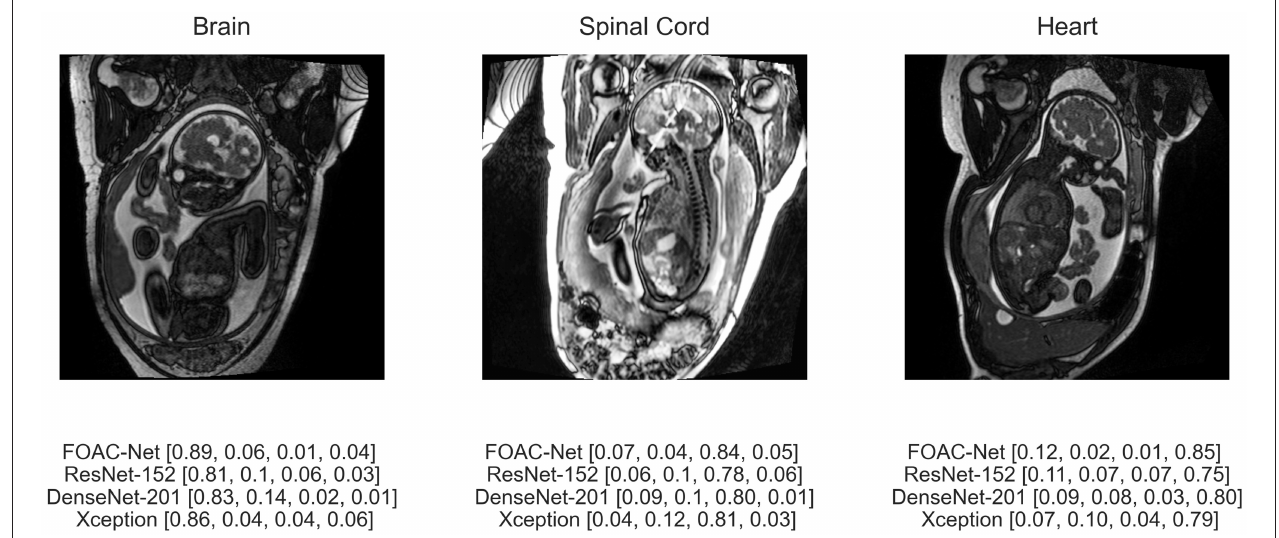
FIGURE 5 | Predicted classification output of FOAC-Net, ResNet-152, DenseNet-201, and Xception (normalized prediction probabilities). Target classes are [brain, normal, spinal cord, heart],